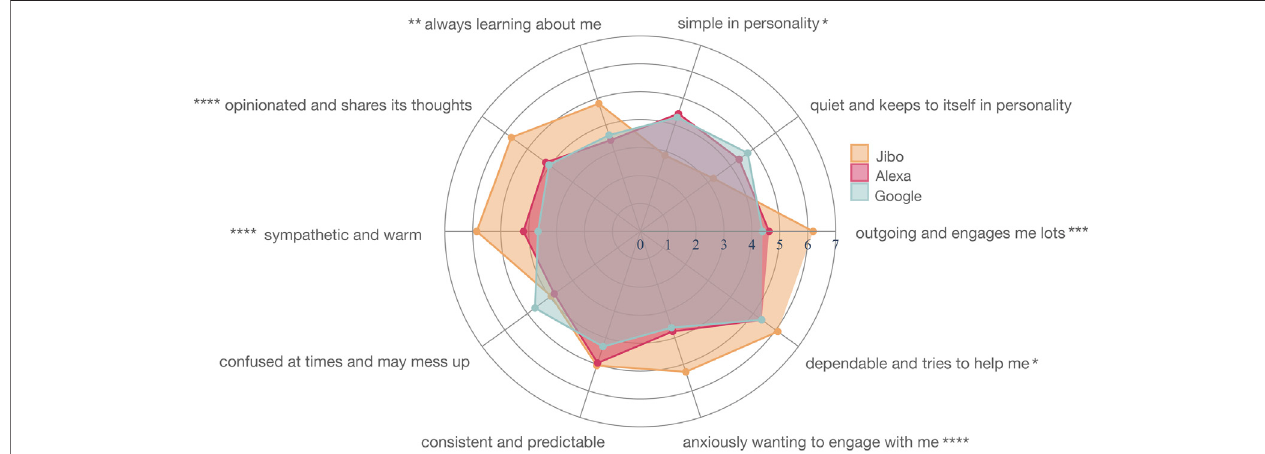
FIGURE 5 | Personality mapping for Jibo (orange), Alexa (red), and Google (blue) in Study 1